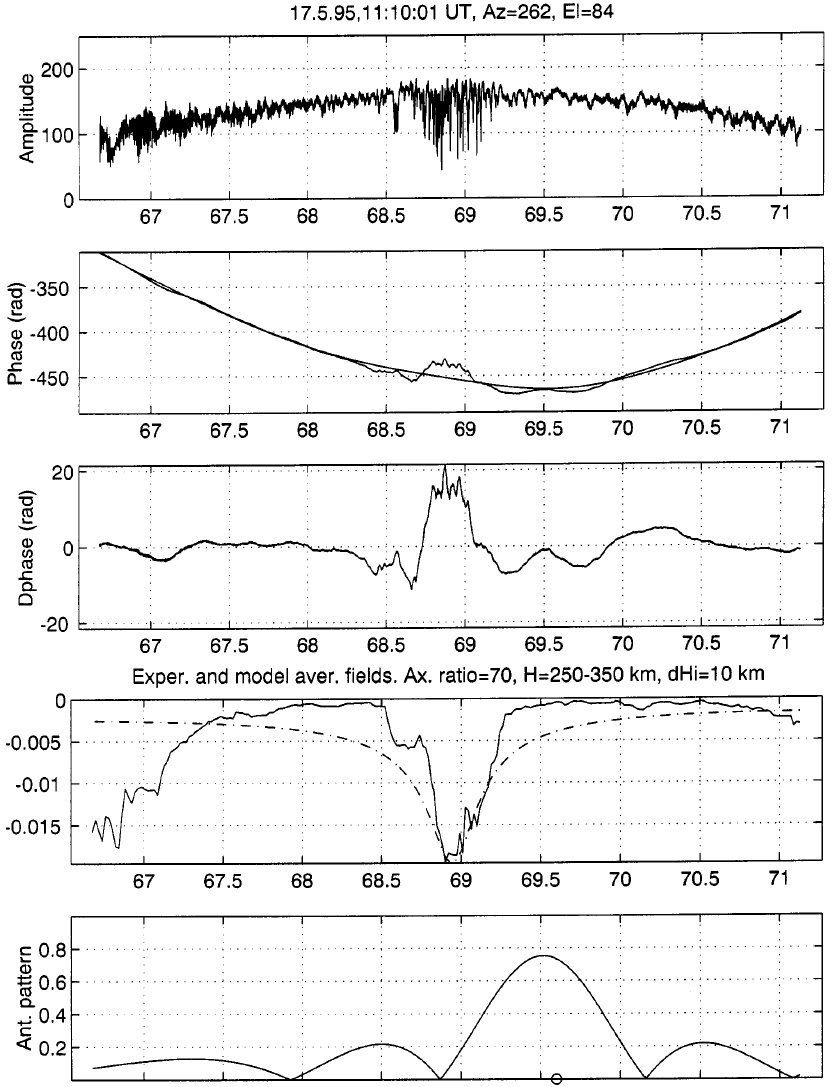
Fig. 2. Same as Fig. 1, but for the satellite pass during the operation of the heating facility. The bottom panel shows the spatial cross section of the calculated antenna pat- tern of the Tromsø facility as a function |sin x / x | using the satellite geometry and the parameters of array 2. The open circle on the x -axis indicates the latitude of the